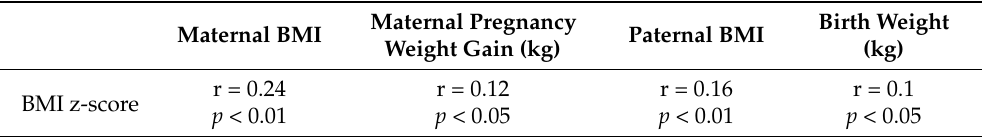
Table 4. Correlation between the BMI z-score, maternal BMI, maternal pregnancy weight gain, paternal BMI, and the child’s birth weight.